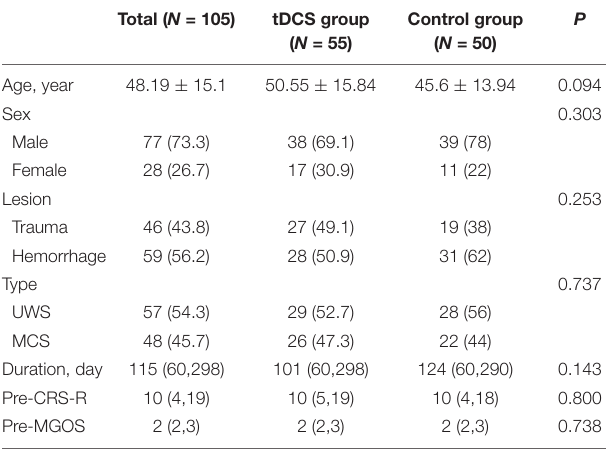
TABLE 2 | Clinical characteristics of the